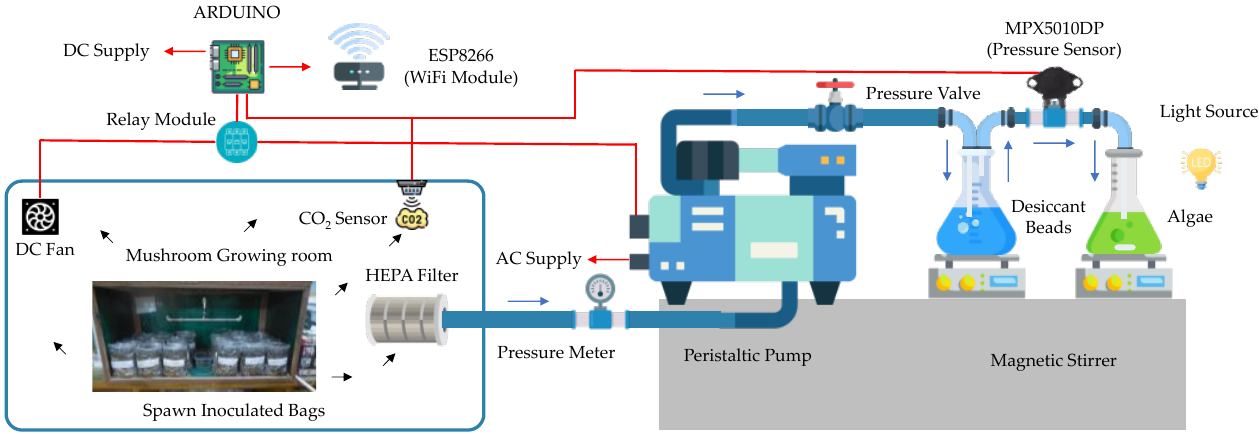
Figure 1. Experimental setup for CO 2 harvesting and sequential algal cultivation (red arrows: prototype connections; black/blue arrows: CO 2 flow directions).